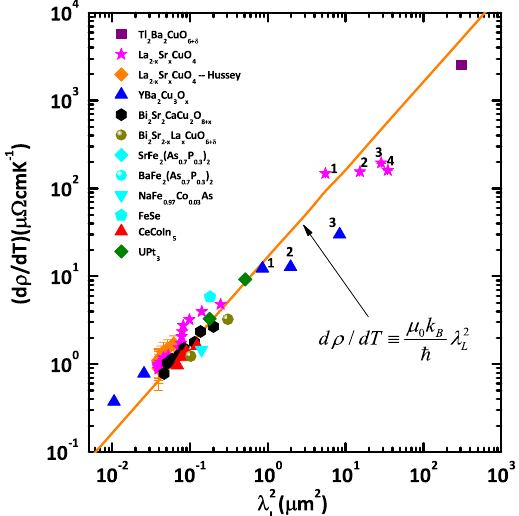
2 for various strongly correlated superconductors. The orange line is the L